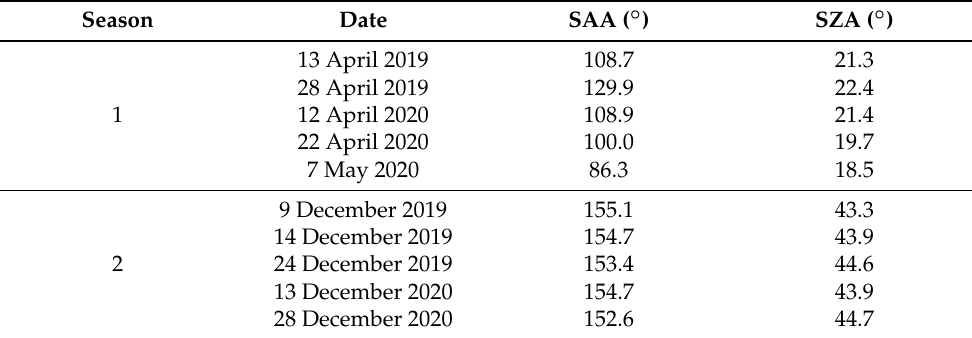
Table 5. Date of Sentinel-2 image acquisition and Sun geometry conditions (Sun azimuth angle (SAA) and Sun zenith angle